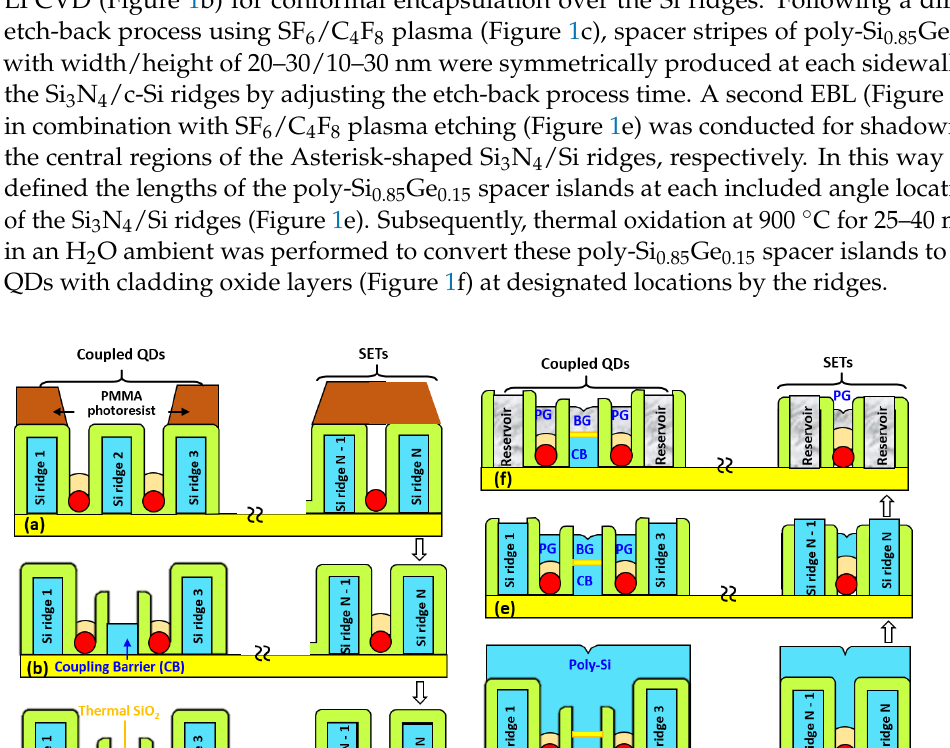
Figure 2. Process flow diagrams showing the fabrication of self-aligned PGs, BGs, and source/drain reservoirs. ( a ) EBL opening of the selected c-Si ridges (ridge #2) that would serve as CBs; ( b ) the removal of the top Si 3 N 4 and the top portion of the selected c-Si ridges (ridge #2) using CHF 3 plasma and SF 6 /C 4 F 8 plasma, respectively, forming CBs; ( c ) the growth of a thin thermal SiO 2 over the CBs; ( d ) deposition of poly-Si overlayers; ( e ) direct etch back of poly-Si overlayers and top Si 3 N 4 over the outmost c-Si ridges (for instance, ridges #1, #3, #N - 1, #N), forming PGs over the Ge QDs and BGs over CBs via SiO 2 layers; ( f ) silicidation of the outmost c-Si ridges, PGs, and BGs, forming polycide reservoirs, PG, and BG, respectively.